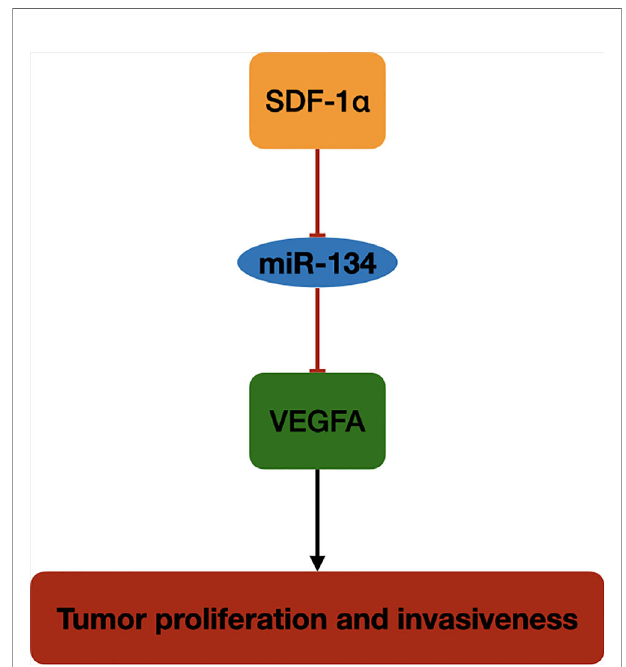
FIGURE 5 | The schematic diagram of SDF-1 a /miR-134/VEGFA axis in NF- PitNET. SDF-1 a promotes VEGFA expression by inhibiting miR-134 expression in NF-PitNETs proliferation and